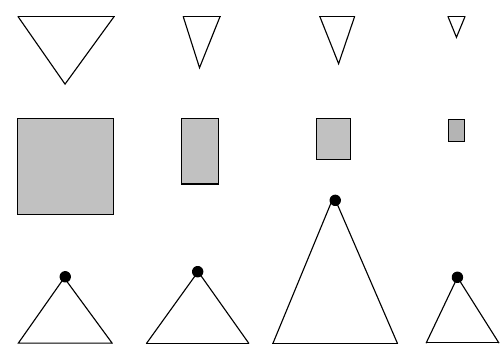
Figure 1. Features of aerial frame cameras. The symbols mean: Columns from left to right: Film-based wide-angle camera, digi- tal large-format frame camera of first generation, digital large- format camera of second generation, and latest medium-format digital frame camera. Rows from top to bottom: Field of view (FOV) in the direction of flight, area of the output image, and flying height for the same ground sampling distance together with FOV across the direction of flight and swath